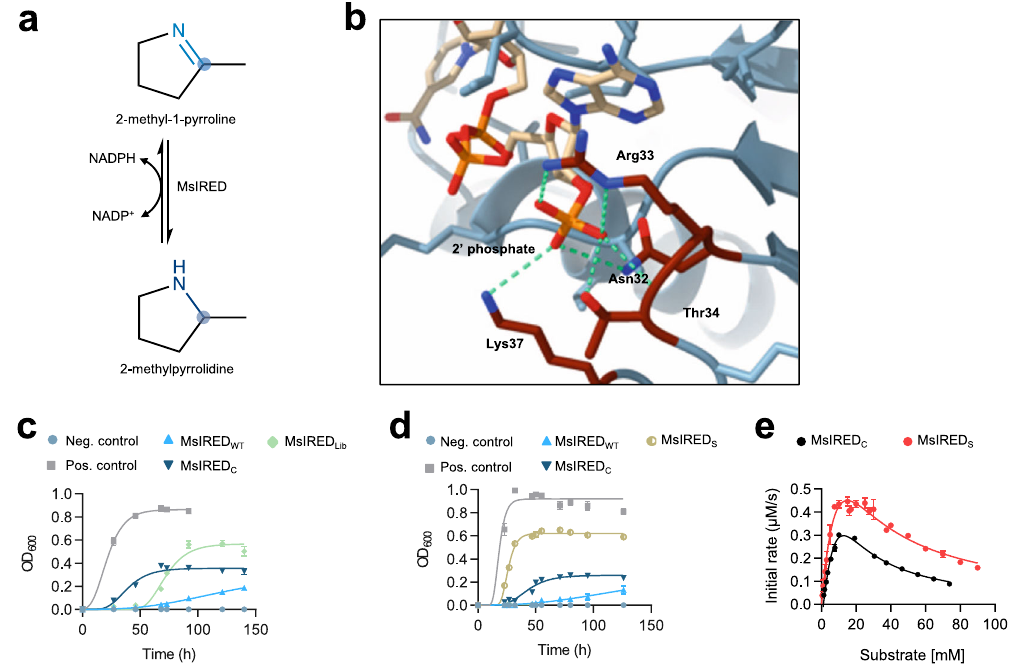
Fig. 4 Selection of an imine reductase with reversed cofactor selectivity and minimized substrate inhibition. a Reaction catalyzed by MsIRED ( Myxococcus stipitatus imine reductase). MsIRED can reduce several imines to the corresponding amine using NADPH as cofactor. b Homology model of the cofactor binding site of MsIRED WT with NADPH bound. The model was generated by threading the MsIRED sequence into PDB code 3ZHB. Residues 32, 33, 34, and 37 were predicted to be close to the 2 ’ phosphate of NADPH. Hydrogen bonds are shown in green. c Anaerobic culture of AL cells transformed with MsIRED WT (pLS130), MsIRED C (with substitutions N32E, R33Y, T34E, K37R, L67I, and T71V; pLS131) and library MsIRED Lib (pLS133) in medium with 2-methyl-1-pyrroline. Controls are as in Fig. 1. d Anaerobic culture of AL cells transformed with MsIRED WT , MsIRED C , and MsIRED S (with substitutions N32D, R33V, T34R, and K37R) in M9 glucose medium with 2-methyl-1-pyrroline. MsIRED S caused the best anaerobic growth of AL cells. e Comparison of enzymatic activity at different concentrations of 2-methyl-1-pyrroline for MsIRED C and MsIRED S . Data points of panels c − e represent mean values, with error bars showing standard deviation. For panels c and d , n = 3 biologically independent cultures for all timepoints of growth curves. For panel e , n = 3 biologically independent assays for all substrate concentrations with both enzymes. Source data are provided as a Source Data fi